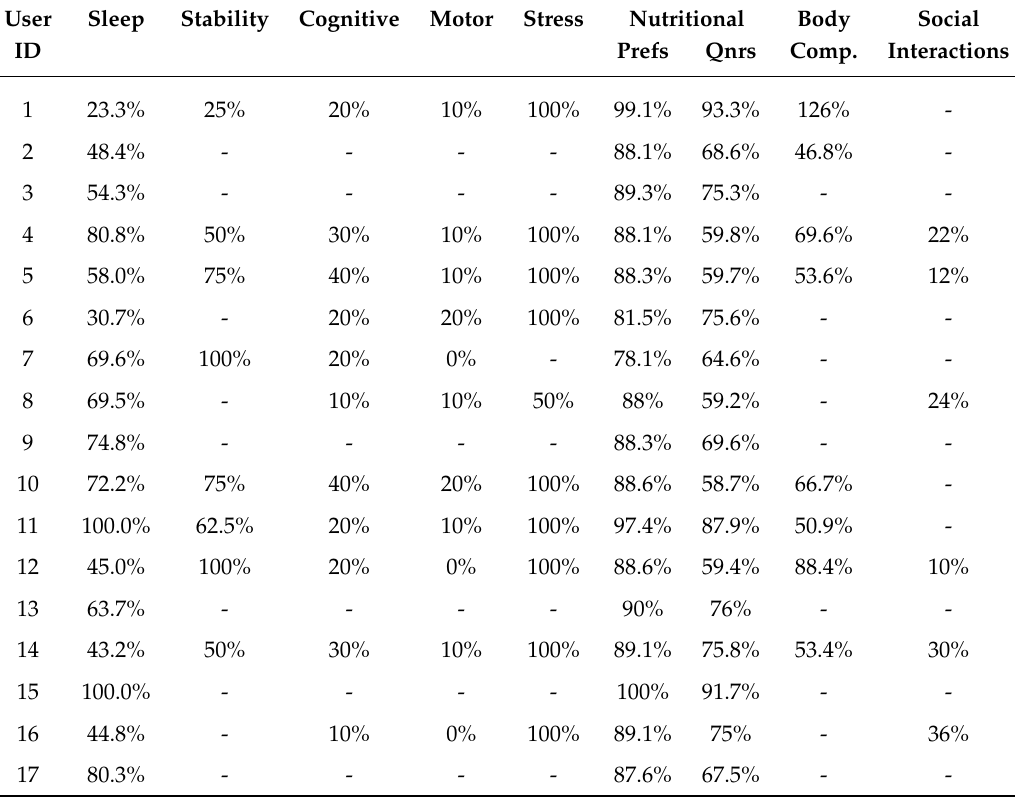
Table 3. Data availability for each